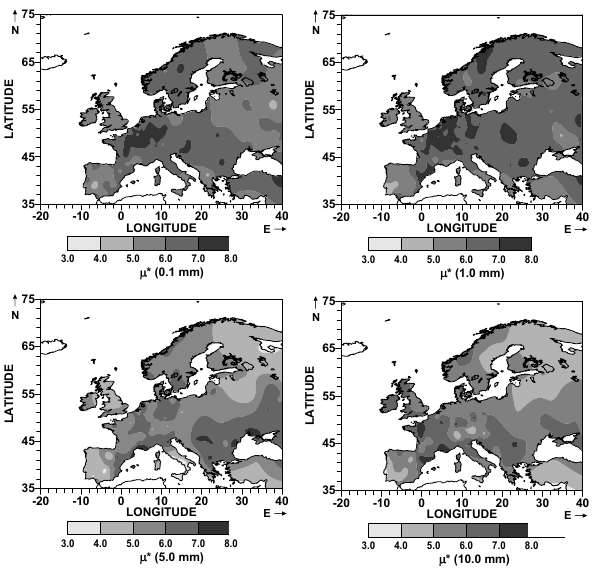
Fig. 9. Spatial distribution of the asymptotic values of the correla- tion dimension for thresholds of 0.1, 1.0, 5.0 and 10.0mm/day.